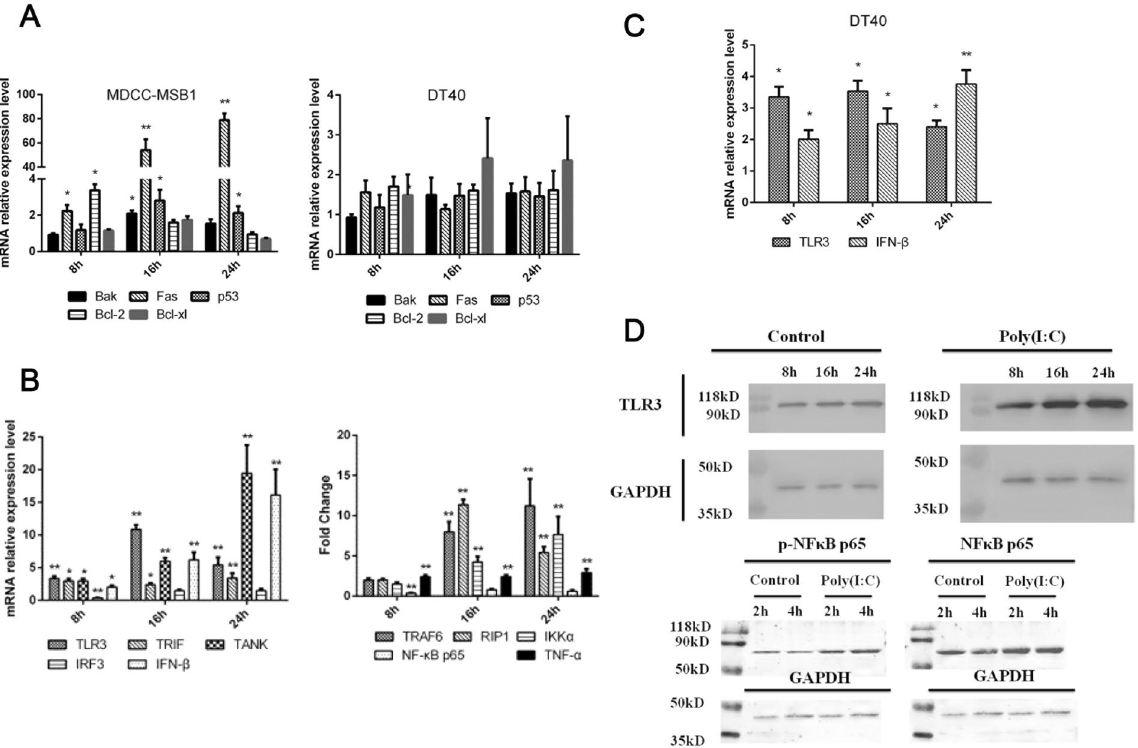
Figure 3. Transcriptional profiling of pro-apoptotic factors and molecules involved in TLR3 pathway in MDCC-MSB1 cells cultured with poly (I:C). ( A ) Transcriptional kinetic of factors associated with apoptosis in MDCC-MSB1 cells and DT40 cells cultured with poly (I:C) (10 μ g/ml) at 8, 16, or 24 h. ( B ) Transcriptional kinetic of molecules involved in TLR3 pathway in MDCC-MSB1 cells cultured with poly (I:C) (10 μ g/ml) at 8, 16, or 24 h. ( C ) Transcriptional kinetic of TLR3 and IFN- β in DT40 cells cultured with poly (I:C) (10 μ g/ml) at 8, 16, or 24 h. ( D ) Expression of TLR3 and phosphorylated NF- κ B p65 in MDCC-MSB1 cells cultured with poly (I:C) (10 μ g/ml) at 8, 16, or 24 h. The asterisk ( * ) or double asterisk ( ** ) respectively indicates p < 0.05 or p < 0.01 in statistical difference from controls. The bars represent an average of multiple